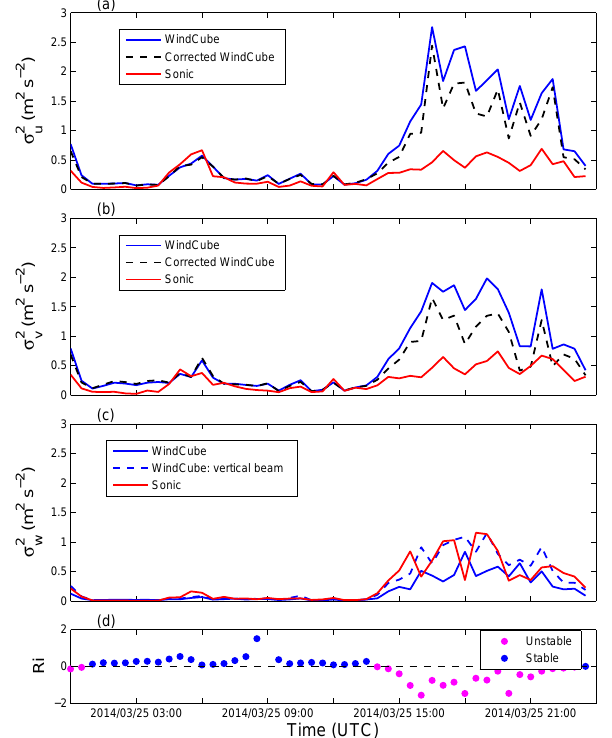
Figure 4. 30min (a) u variance, (b) v variance, and (c) w variance at 100m from sonic anemometers and WindCube DBS technique at BAO and (d) Richardson number calculated from tower data. Data are shown from 25 March 2014. In (a) and (b) , solid blue line indi- cates DBS-calculated variance and dashed black line indicates cor- rected variance. In (c) , solid blue line indicates DBS-calculated w variance and dashed blue line indicates w variance calculated from vertically pointing beam. The corrected u and v variance data show substantial improvement over the uncorrected data set during unsta- ble